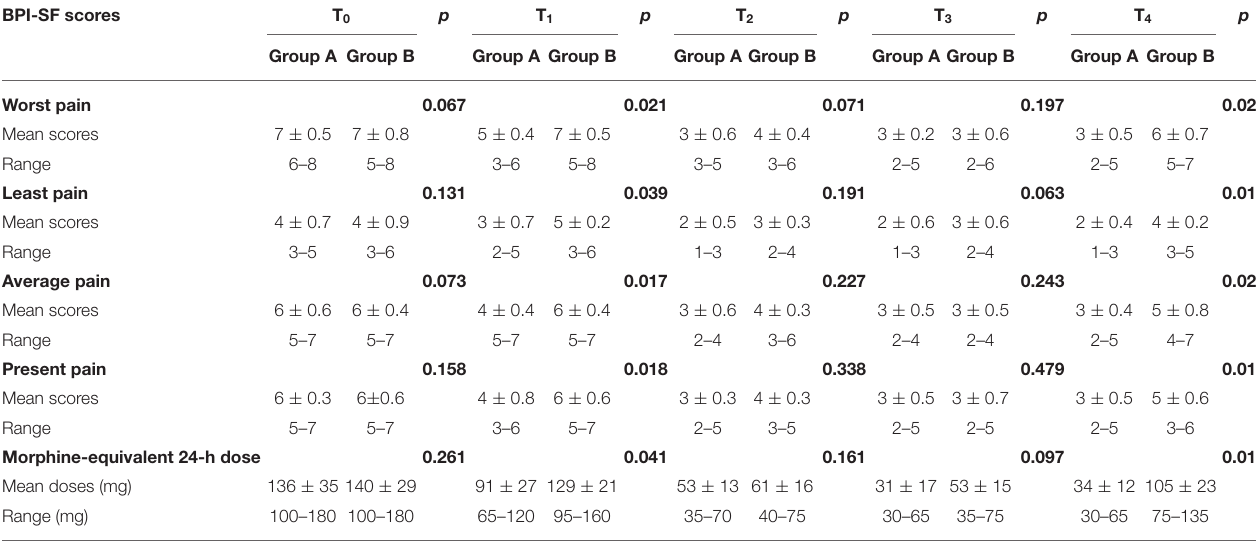
TABLE 2 | Pain-related variables and score from different therapy strategies. BPI-SF scores